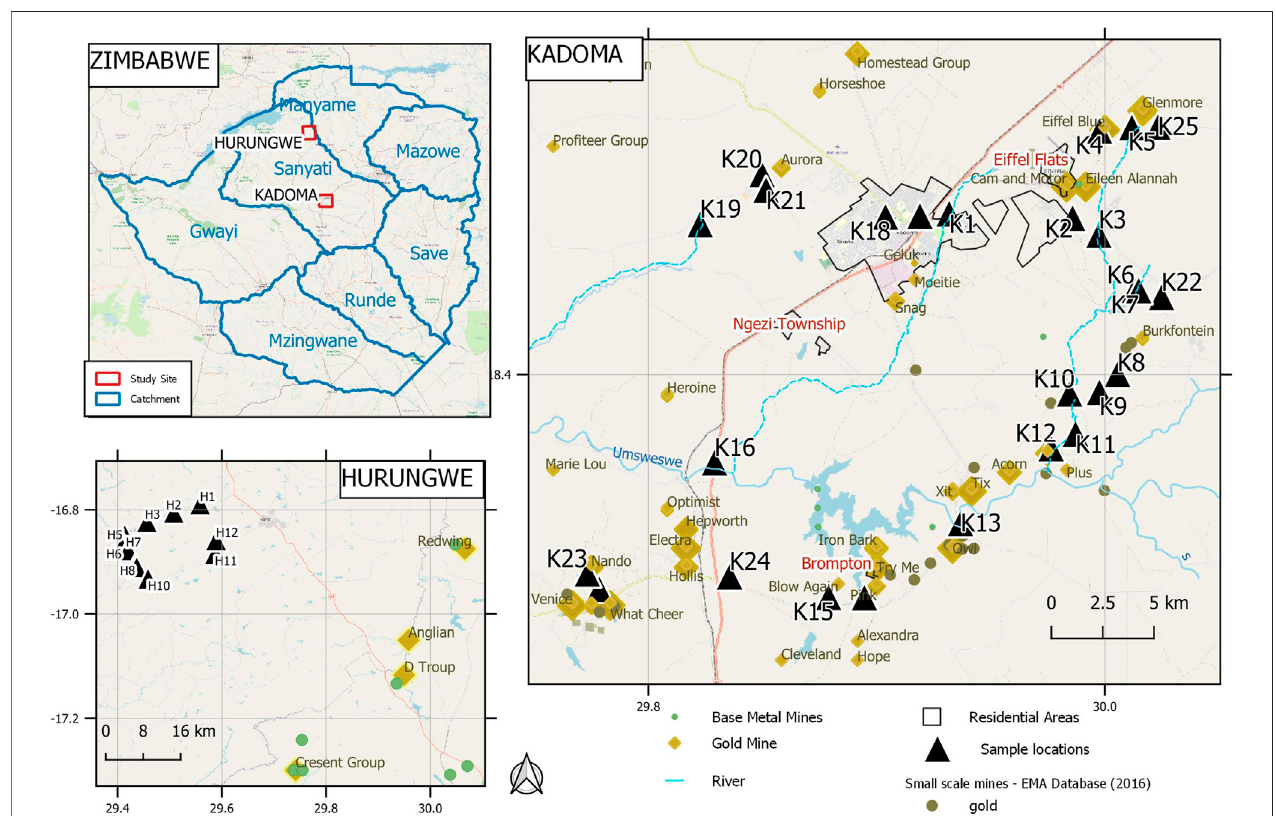
FIGURE 2 | Overview of the sample sites and locations of mines in the Sanyati